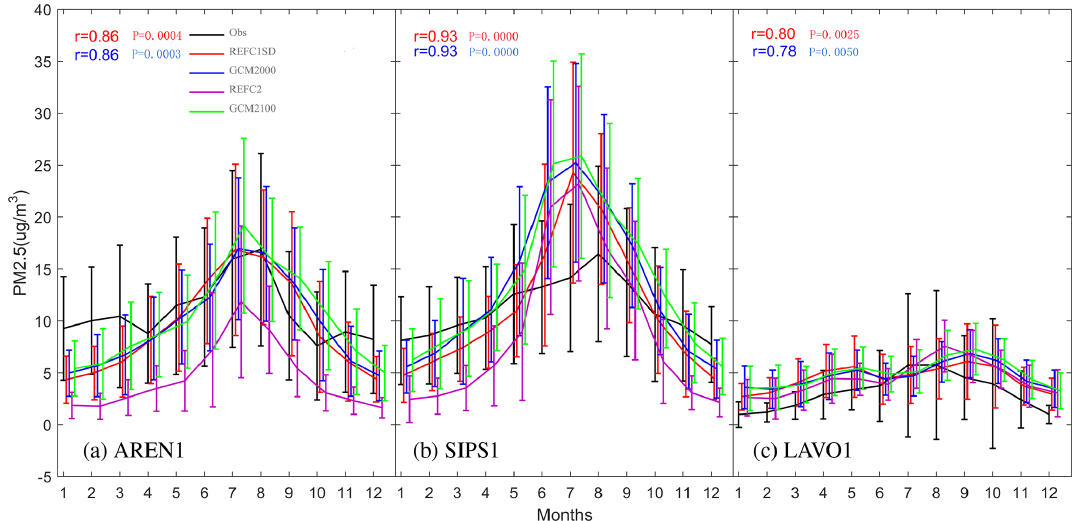
Figure 2. Climatological monthly mean average with standard deviation for PM 2 . 5 used in this study at three sites (AREN1 a , SIPS1 b and LAVO1 c ) for five scenarios used in this study. Red ( r ) represents the correlation coefficient between observation (Obs) and simulation for current from the REFC1SD simulation. Blue r represents the correlation coefficient between observation (Obs) and simulation for current from GCM2000 simulation. The p values are included.